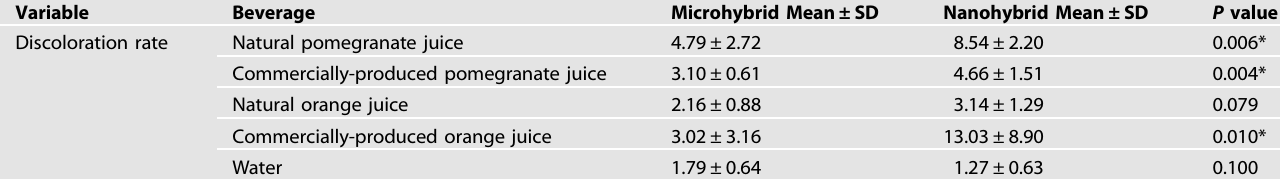
Table 3. Comparing discoloration rate of microhybrid and nanohybrid composites exposed to natural and commercially-produced juices. Variable